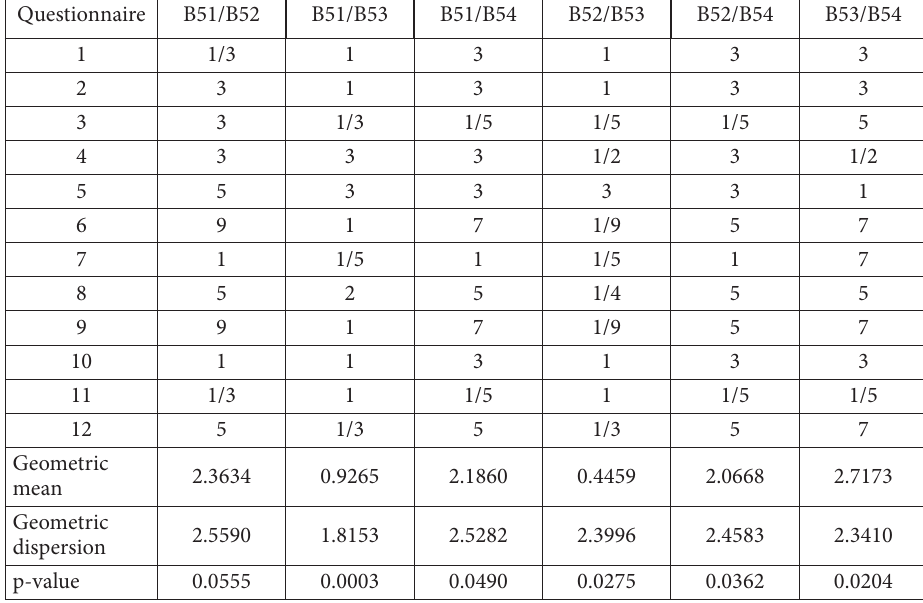
Table 9. Judgments, geometric means, and p -value of industry environment criteria